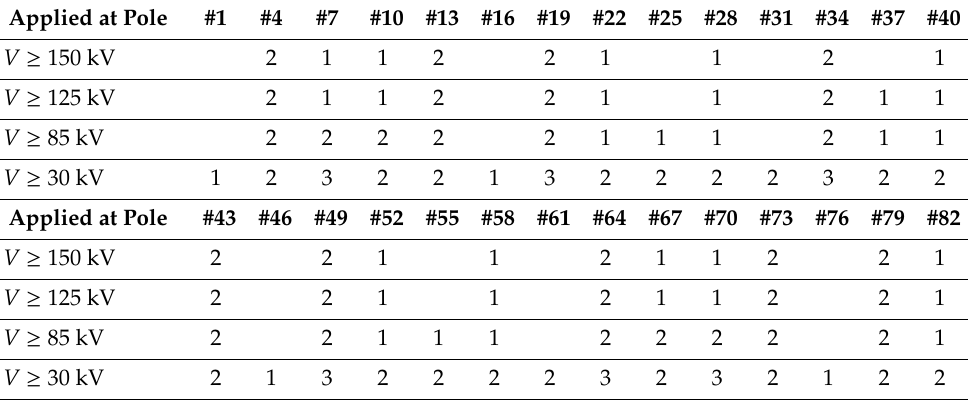
Table 13. Number of transformers with at least one phase reaching the critical overvoltage level. Case 4, dry poles, sub-configuration C4.1 with no grounded intermediate